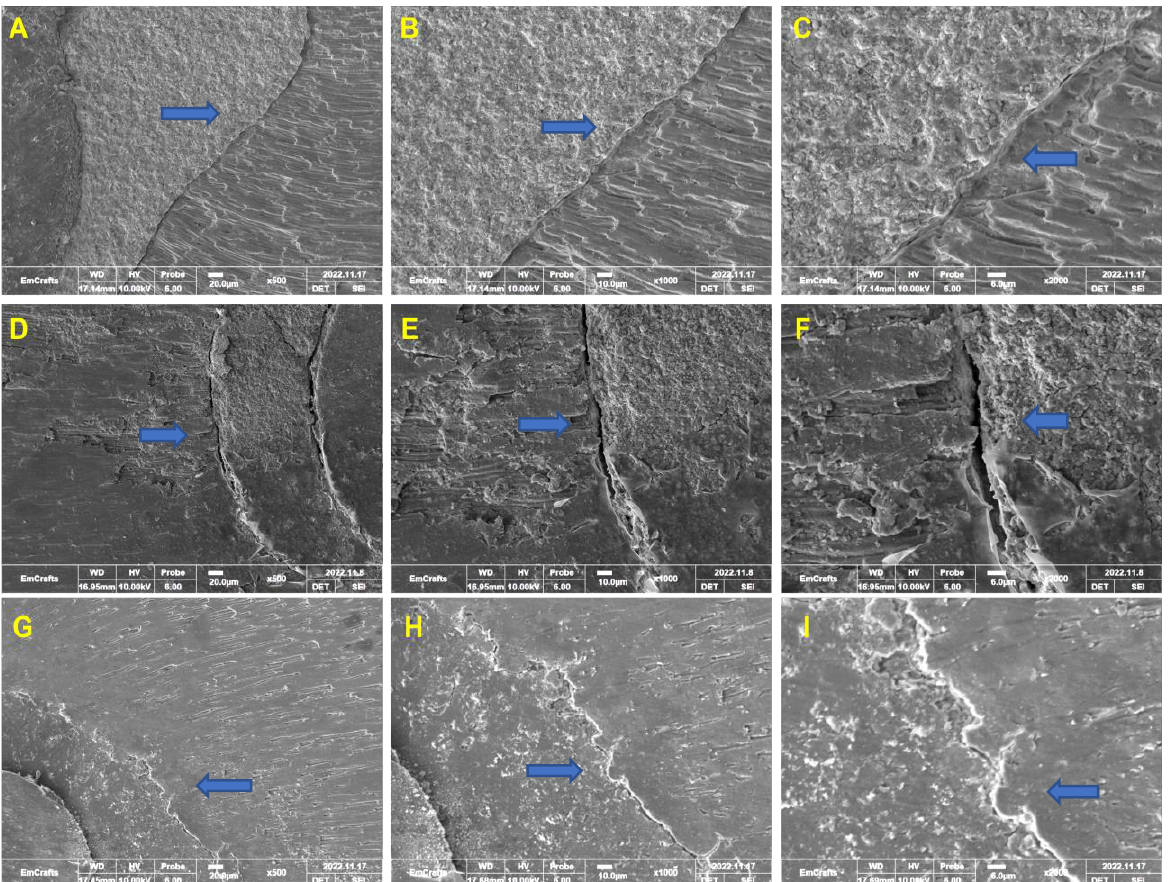
Figure 3. Scanning electron microscope micrographs after 60 days showing the sealer/dentin interface at magnifications of ×500, ×1000, and ×2000, respectively, for the tested groups. ( A – C ) Different magnifications of the MF group showing MTA Fillapex with the best adaptation at the root canal dentin-sealer interface (blue arrows). ( D – F ) Different magnifications of the CE group showing CeraSeal bio-ceramic sealer with marked interfacial gaps at the root canal dentinal wall/sealer interface (blue arrows). ( G – I ) Different magnifications of the CO group showing AH Plus with good adaptation with minor interfacial gaps at the root canal dentinal wall/sealer interface (blue arrows).